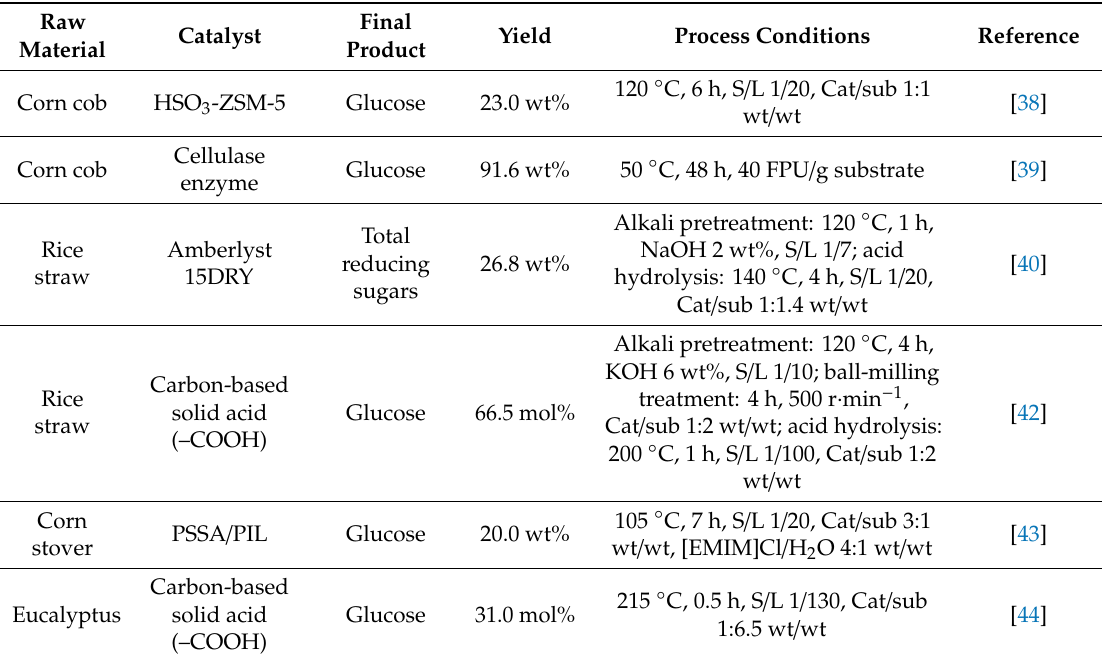
Table 2. Literature review of cellulose hydrolysis with heterogeneous